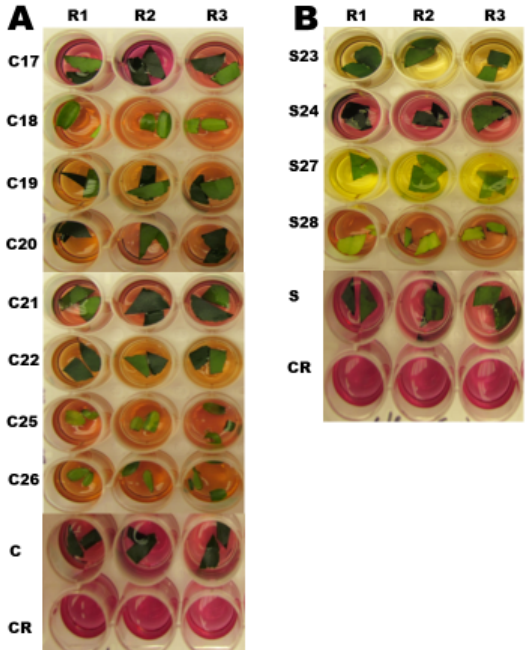
Figure 4. The chlorophenol red pH indicator test for phosphomannose isomerase (PMI). Transgenic, wild-type, and solution alone samples were tested with Murashige and Skoog (1962) plus mannose medium and chlorophenol red pH indicator. A red or purple color indicates negative phosphomannose isomerase activity and an orange or yellow color indicates positive PMI activity. ( A ) Replicated Carrizo samples, Rows C17, C18, C19, C20, C21, C22, C25, C26 : Leaves of Citrus sinensis Osb. x Poncirus trifoliata L. Raf. (‘Carrizo’ citrange) transgenics. Row C: Leaves of wild-type ‘Carrizo’, Row CR : Chlorophenol red solution alone. ( B ) Replicated Swingle samples, Rows S23, S24, S27, S28 : Leaves of Citrus paradisi Macf. Duncan grapefruit x Poncirus trifoliata L. Raf (‘Swingle’ citrumelo) transgenics. Row S : Leaves of Wild-type ‘Swingle’, Row CR : Chlorophenol red solution alone, R1–R3: Three replicates.